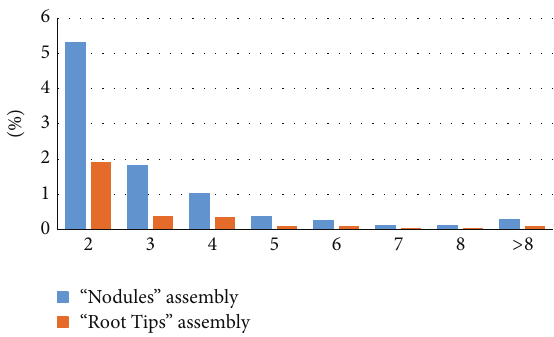
Figure 2: Isoform distribution in “Nodules” and “Root Tips”